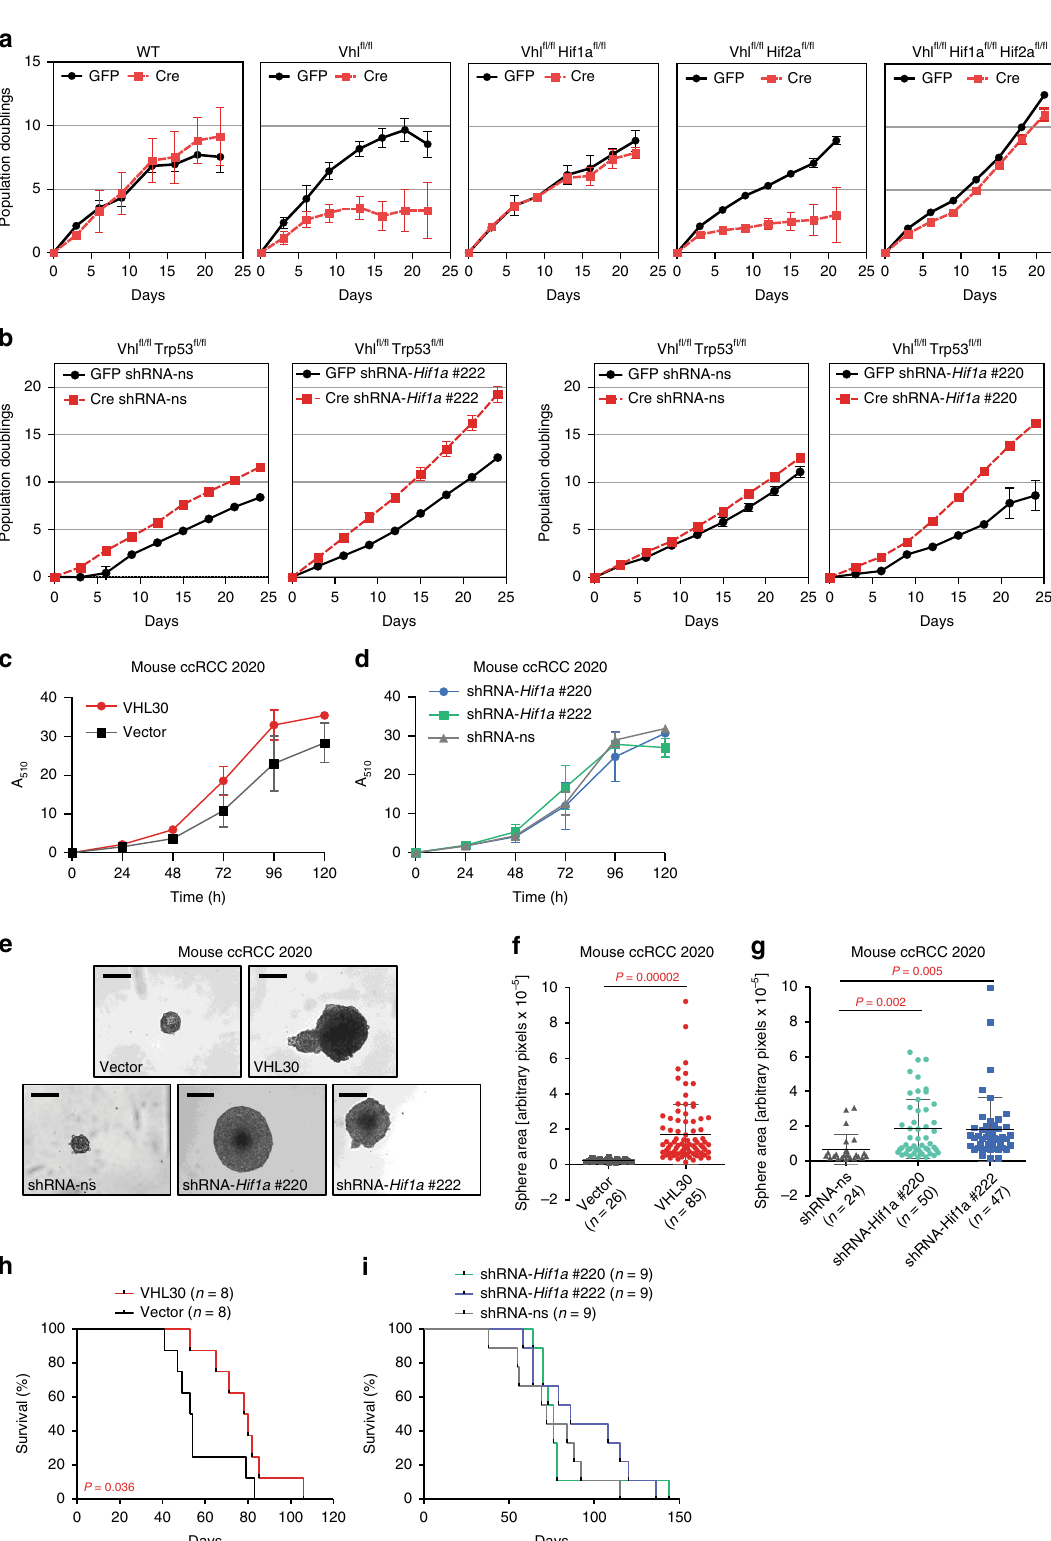
potentially consistent with the slower rate of growth of Vhl Δ / Δ GAGE terms that might be relevant to the evolution and proliferation included genes that are targets of the MYC and E2F